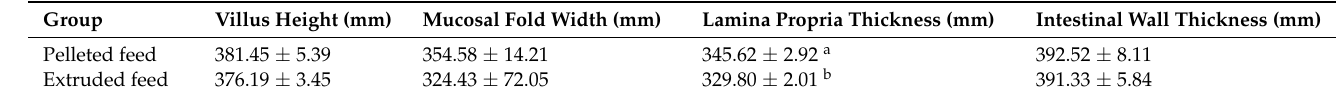
Table 6. Effects of pelleted and extruded feeds on intestinal microscopic structure of P. clarkii .